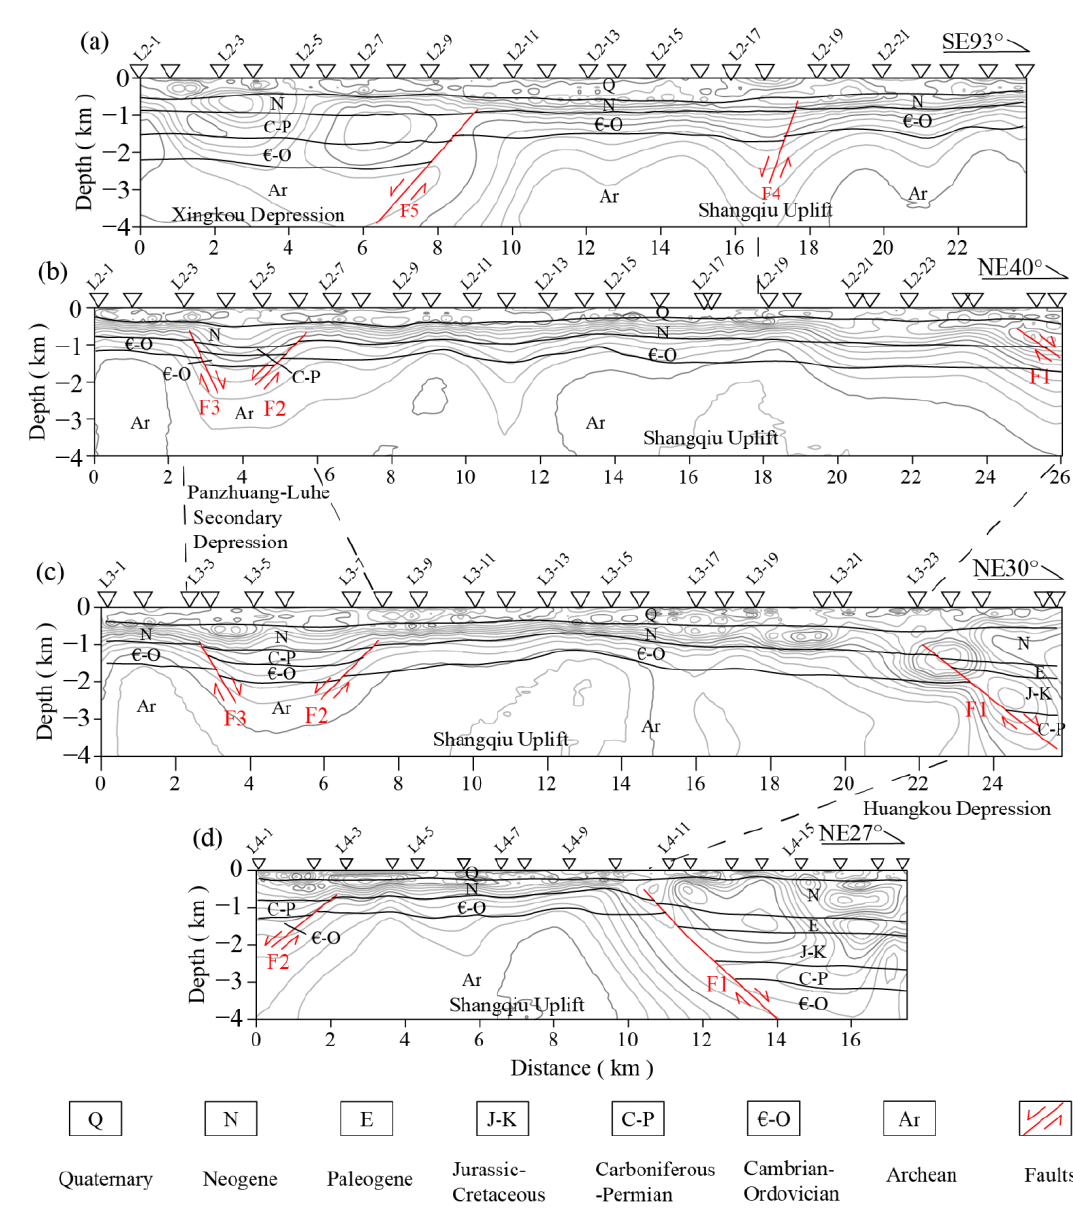
Figure 7. Possible interpretation of faults and strata in the study area according to the 2D resistivity models. Triangles with labels are MT stations. F1: Jiaozuo-Shangqiu fault, F2: South Shangqiu fault, F3: Luhe fault, F4: Ningling fault, and F5: Suixian fault. ( a – d ) Interpretation of L1, L2, L3 and L4, respectively.